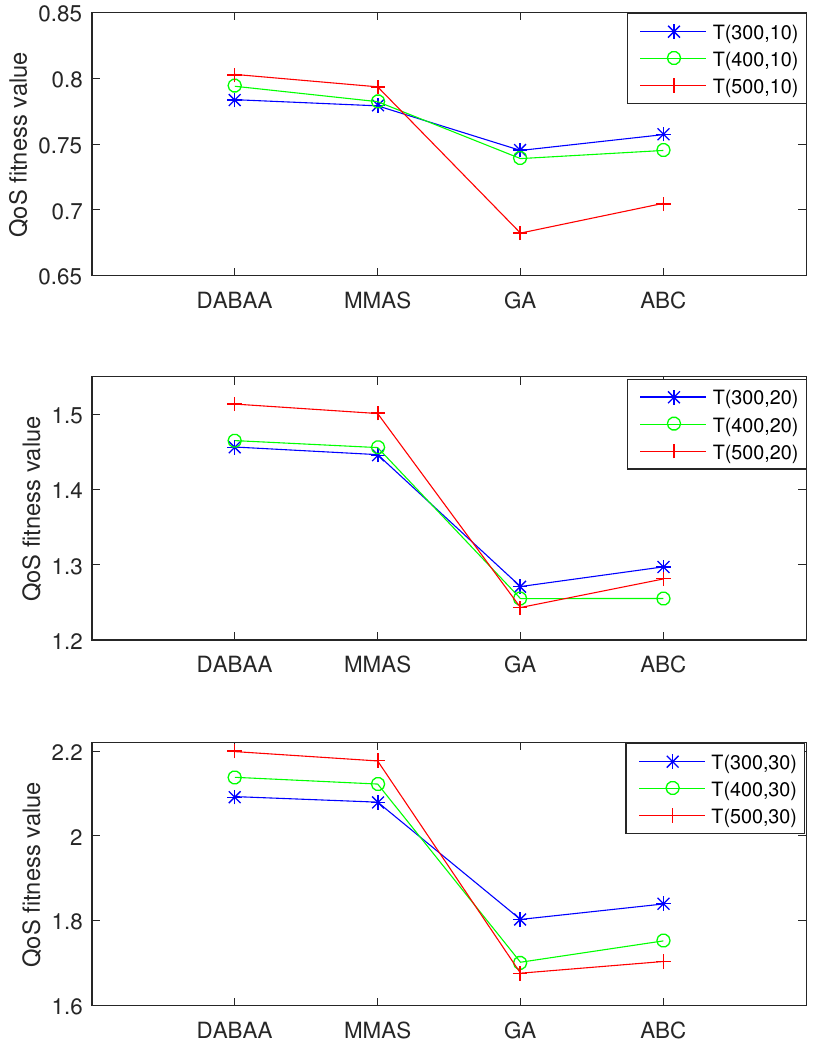
Figure 5. Results of accuracy with different task